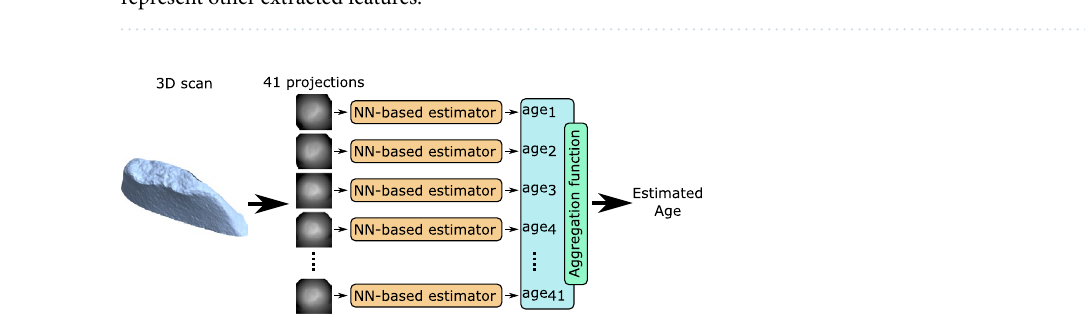
Figure 4. Examples illustrating the feature extraction used in the SASS method. ( a ) Top view of the Dirichlet normal energy distribution over the symphyseal surface. The yellow colour indicates a higher value of the Dirichlet normal energy. The standard deviation of the Dirichlet normal energy computed over the entire surface represents a single feature. ( b ) Detected ellipses over the surface. The yellow colour indicates the highest areas of the scan. The ellipse major axis corresponds to the dominant orientation of the underlying area. The total number of detected ellipses and the number of ellipses with certain orientation (horizontal, vertical) represent other extracted features.